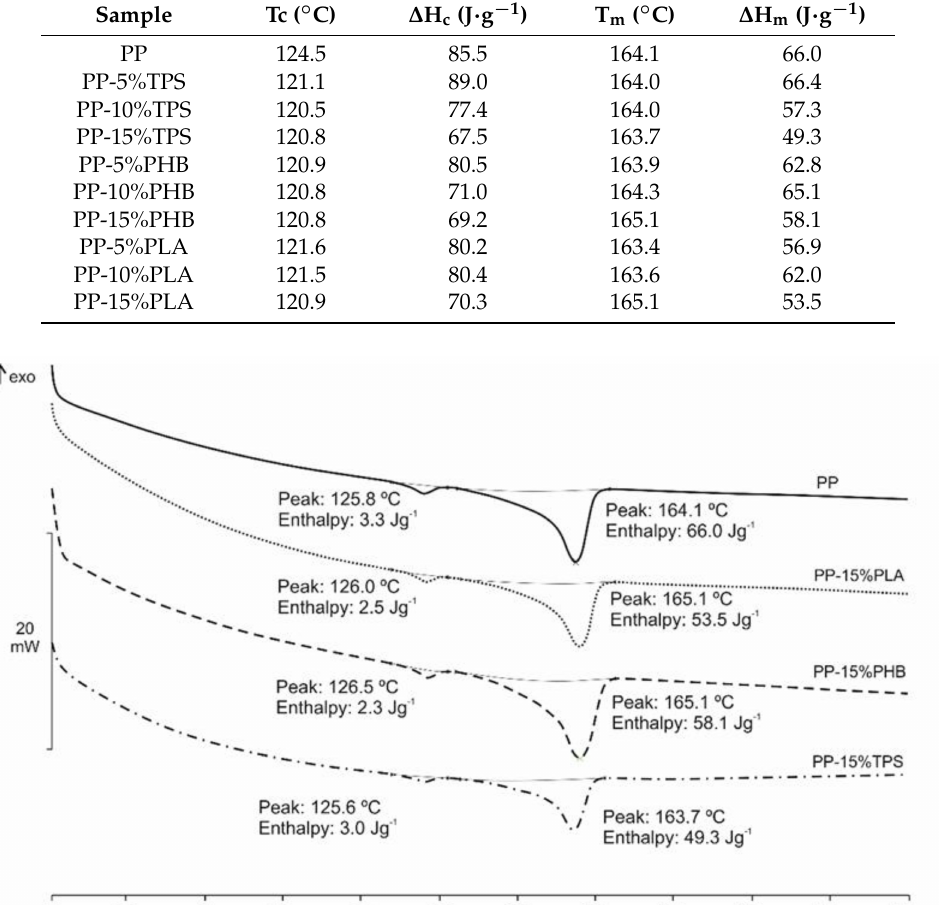
Table 4. DSC results of PP blends with biodegradable polymers.